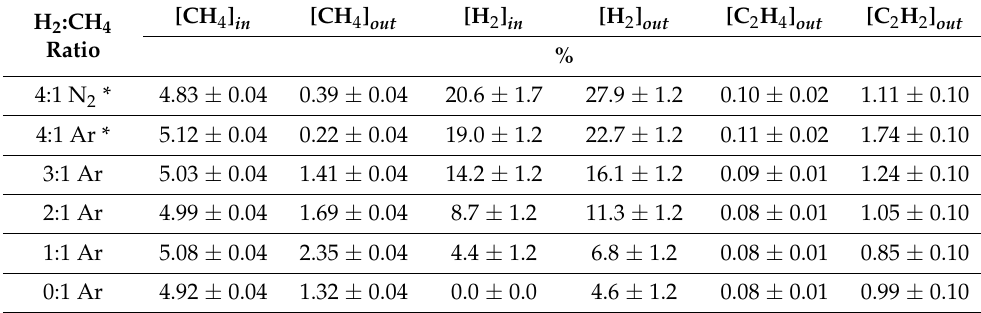
Table 1. Inlet and outlet concentrations of the main gaseous